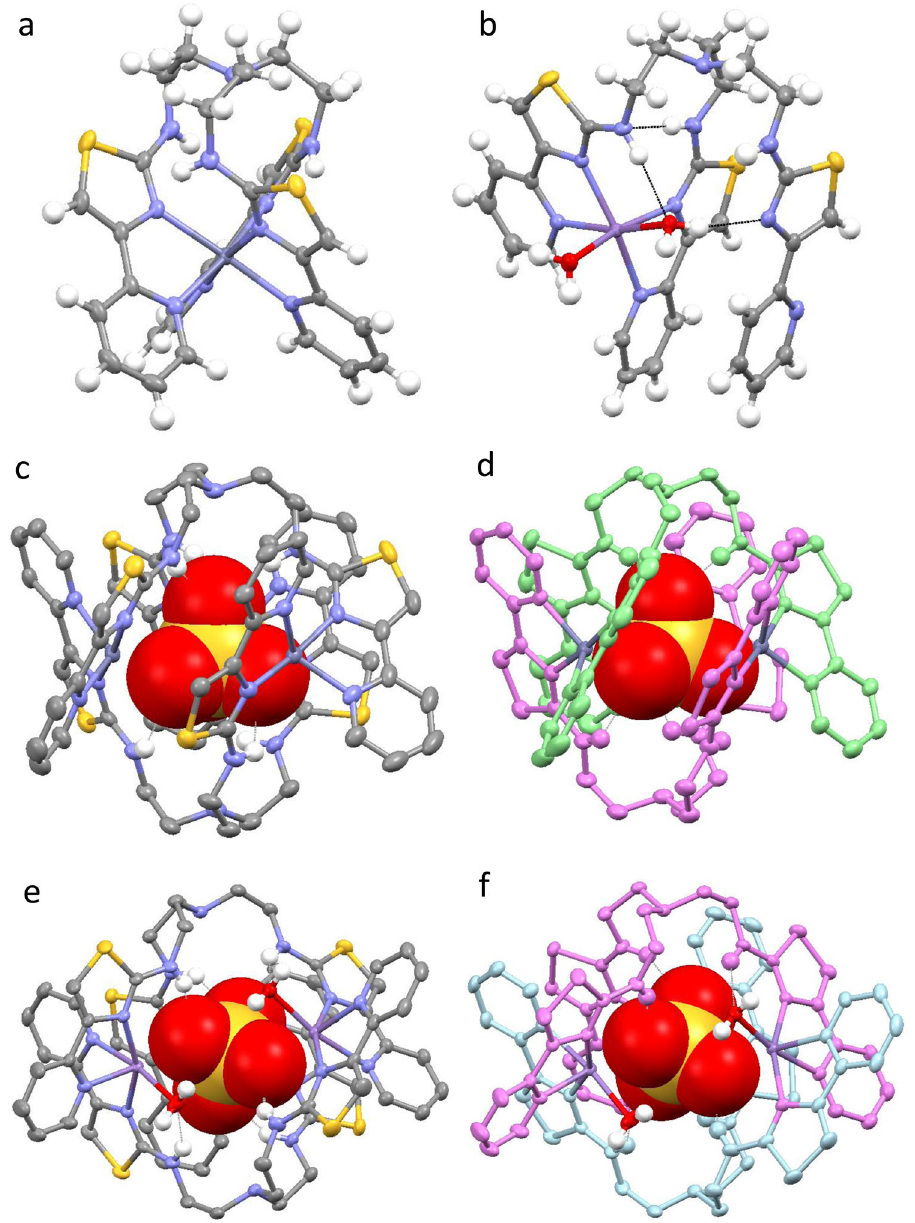
Fig. 2 Single-crystal X-ray structures of metal-containing complexes of L. a [LZn] 2 + . b [ L Mn(H 2 O) 2 ] 2 + . c [ L 2 Zn 3 (SO 4 )] 4 + . d [ L 2 Zn 3 (SO 4 )] 4 + . e [ L 2 Mn 3 (H 2 O) 2 (SO 4 )] 4 + . f [ L 2 Mn 3 (H 2 O) 2 (SO 4 )] 4 + . Colour code: dark blue, Zn(II); purple, Mn; red, O; blue, N; yellow, S; grey, C (apart from 2d and 2f where the ligand strands have been coloured for